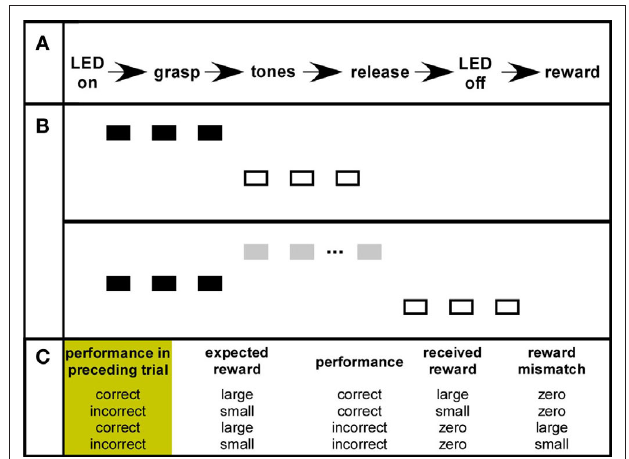
Figure 1 | (A) The behavioral paradigm. (B) Tone sequences with a downward frequency step and tone sequences with both an upward and a downward frequency step. The monkeys’ task was to identify downward steps (C) The standard performance-dependent reward-rule. See Section “Materials and Methods” for